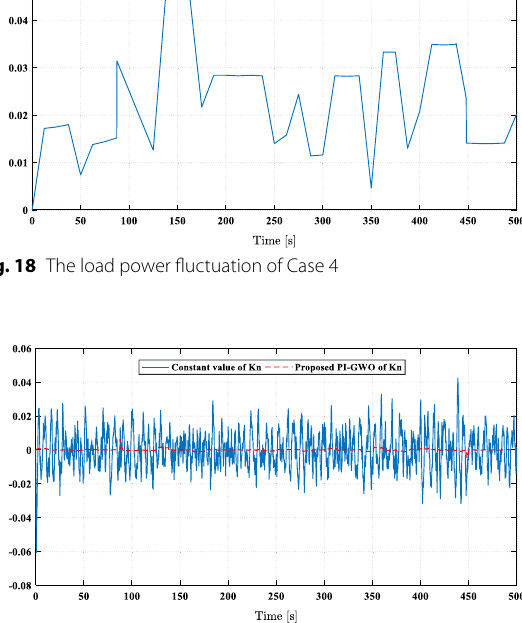
Fig. 19 The frequency deviation of Case 4